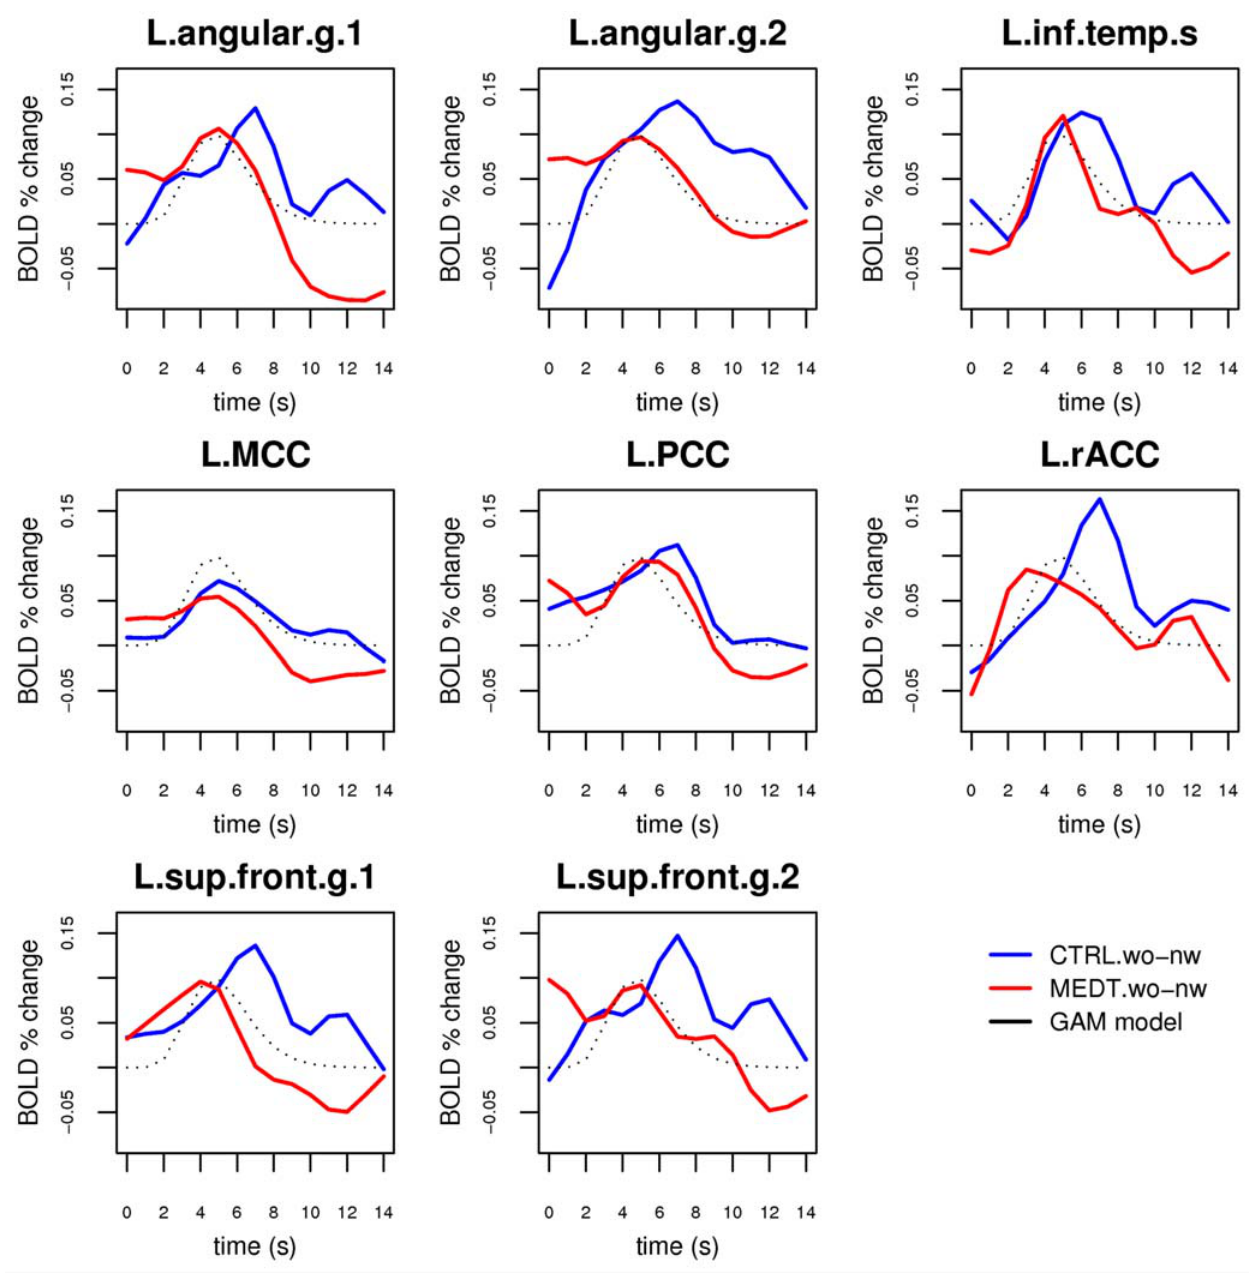
Figure 3. Estimates of the BOLD response associated with semantic processing in the ROI set, obtained by fitting a spline basis set model for the hemodynamic function and subtracting the average response to nonwords (‘‘nw’’) from the average response to words (‘‘wo’’) in meditators and controls. The Gamma function model for a standard hemodynamic response is plotted as a black dotted line for reference.